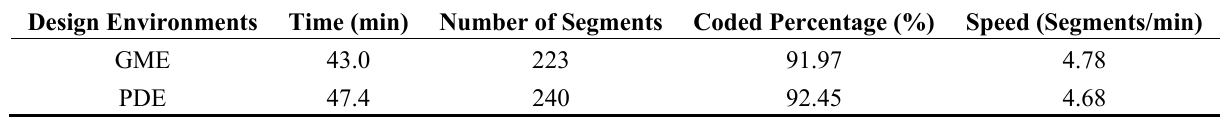
Table 2. General coding